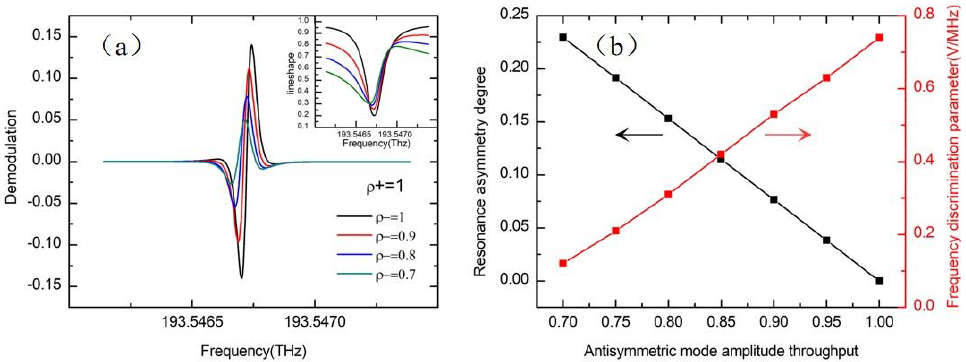
Figure 9. ( a ) The influence of the normal mode effect on the resonance curve and the demodulation curve. ( b ) Effect of the normal mode on the resonance asymmetry degree and the frequency discrimination parameter of the gyroscope. The modulation frequency is 2 MHz.